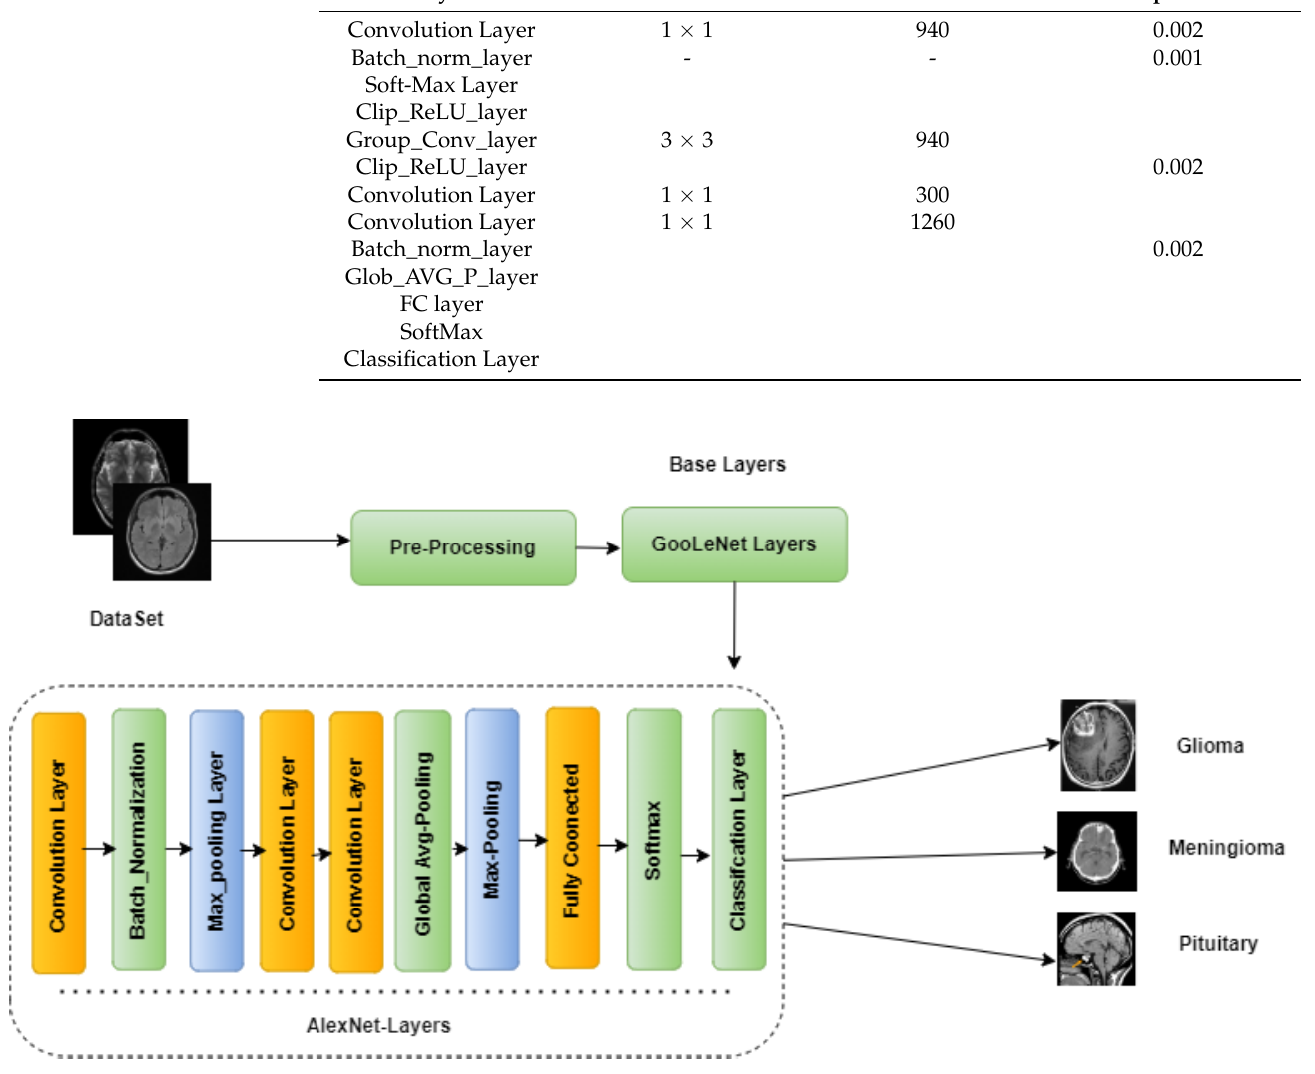
Figure 5. The proposed GN-AlexNet.